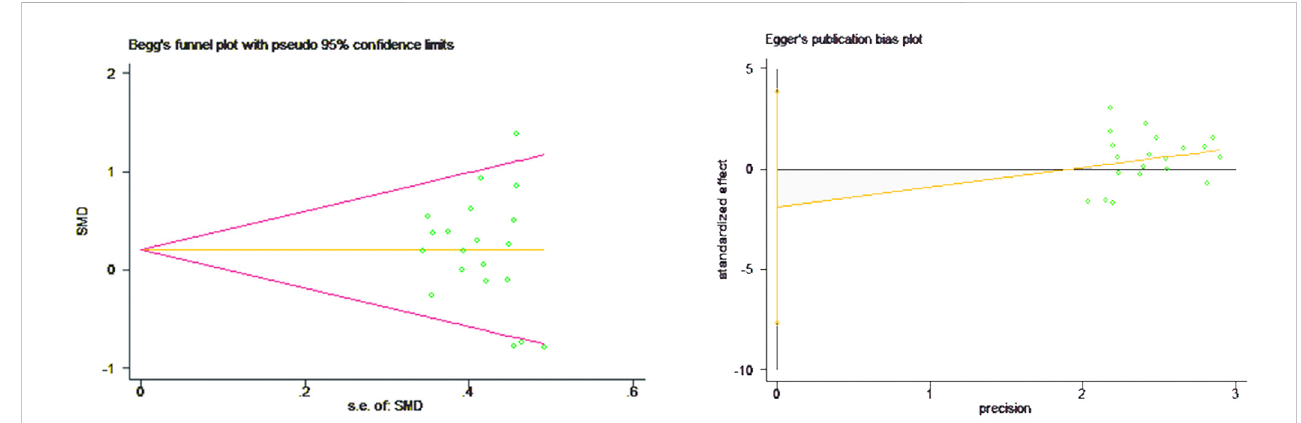
FIGURE 6 Bias analysis of the impact of concurrent training sequence on lower limb strength.